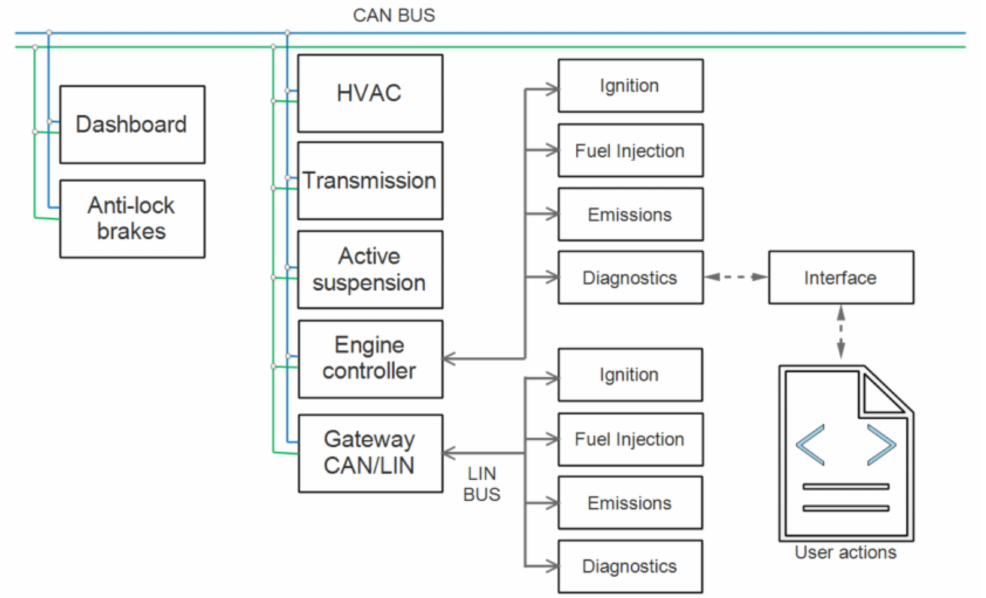
Figure 2. The vehicle nodes and network structure connected to the Controller Area Network (CAN) [10]. The user actions are accessible through the diagnosis interface.